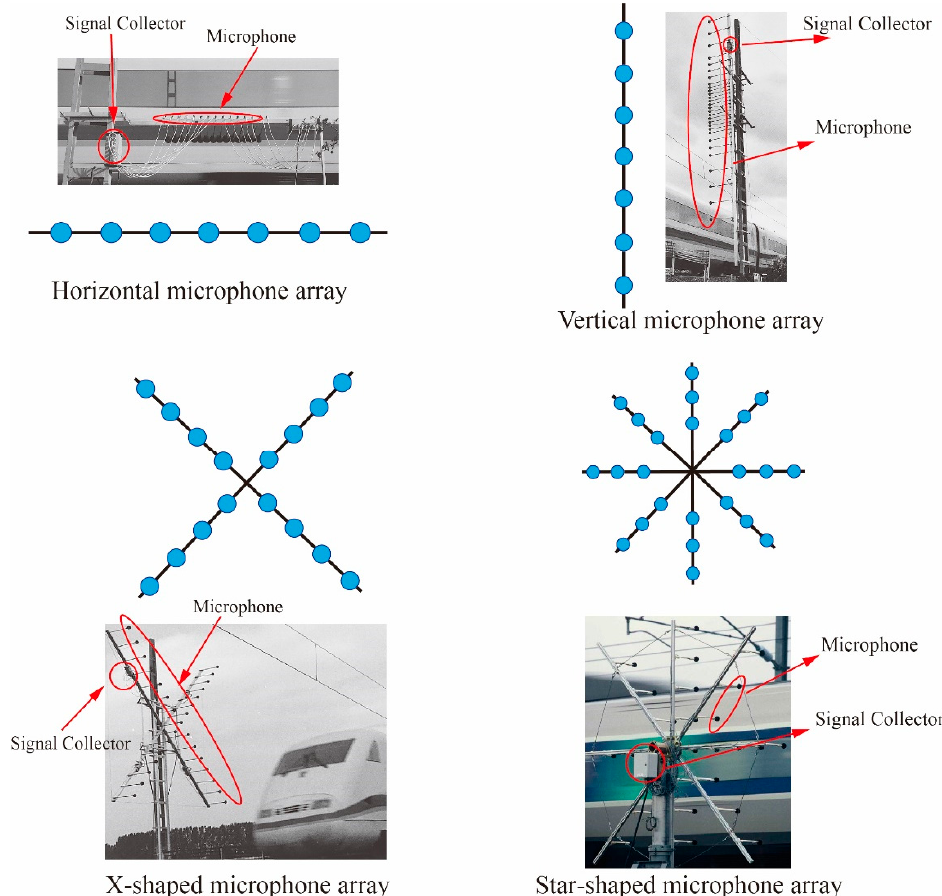
Figure 1. Microphone array arrangement form [45,46].